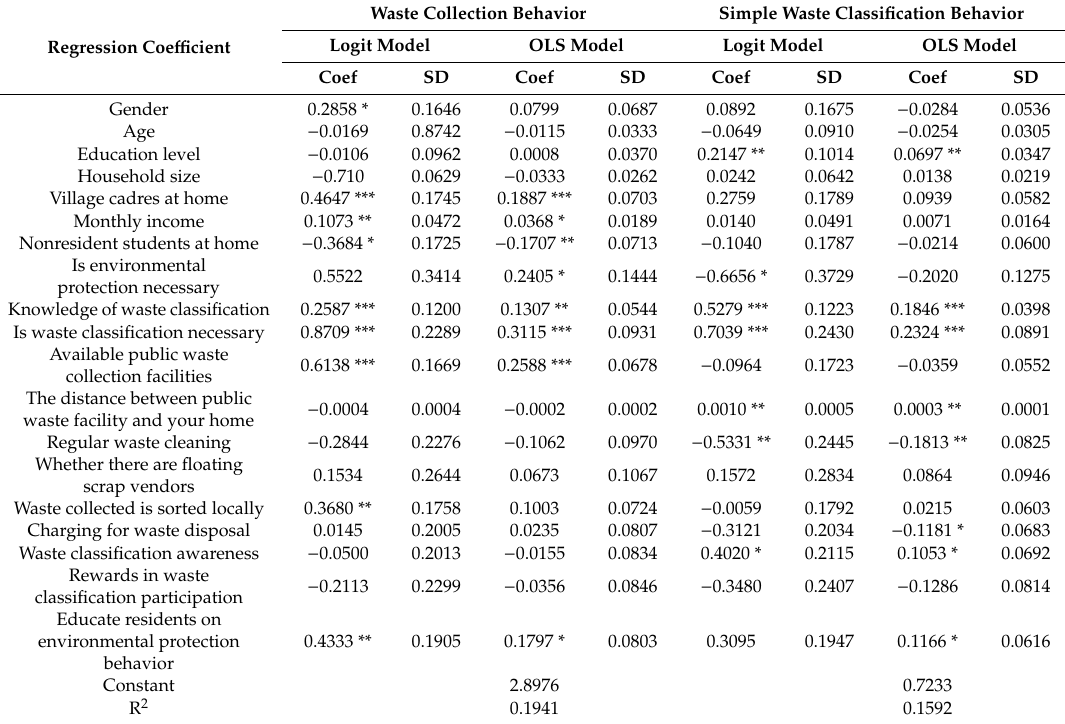
Table 5. Research model analysis outcome of household waste classification